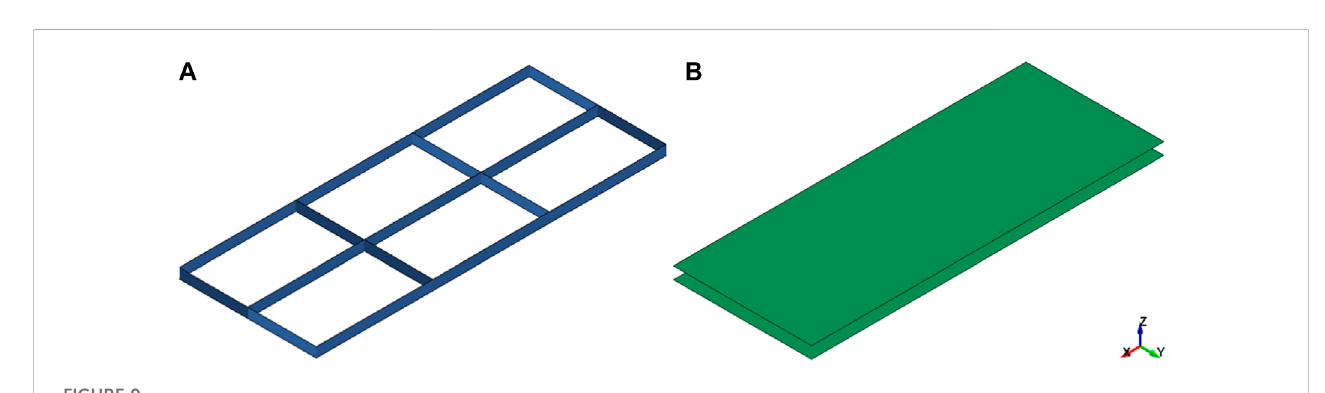
Support structure (A) , Plate structure (B)